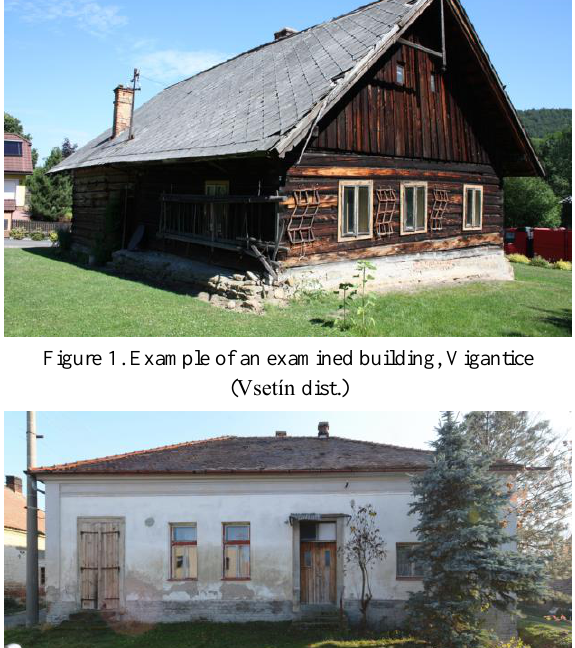
Figure 2. Example of an examined building, Úhřetická Lhota (Pardubice